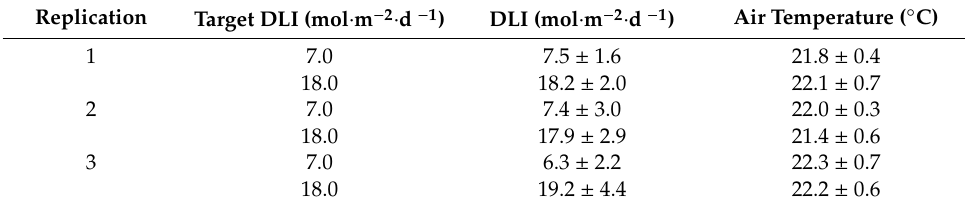
Table 1. Average (mean ± sd ) daily light integral (DLI) and air temperature for hydroponic cilantro ( Coriandrum sativum ‘Santo’), dill ( Anethum graveolens ‘Fernleaf’), and parsley ( Petroselinum crispum ‘Giant of Italy’) grown in nutrient-film technique hydroponic systems with a range of nutrient solution electrical conductivities (EC; 0.5 to 4.0 dS · m − 1 ) in a greenhouse under a low (~7 mol · m − 2 · d − 1 ) or high (~18 mol · m − 2 · d − 1 ) daily light integral (DLI) for 4 weeks. Data are presented for three replications of the